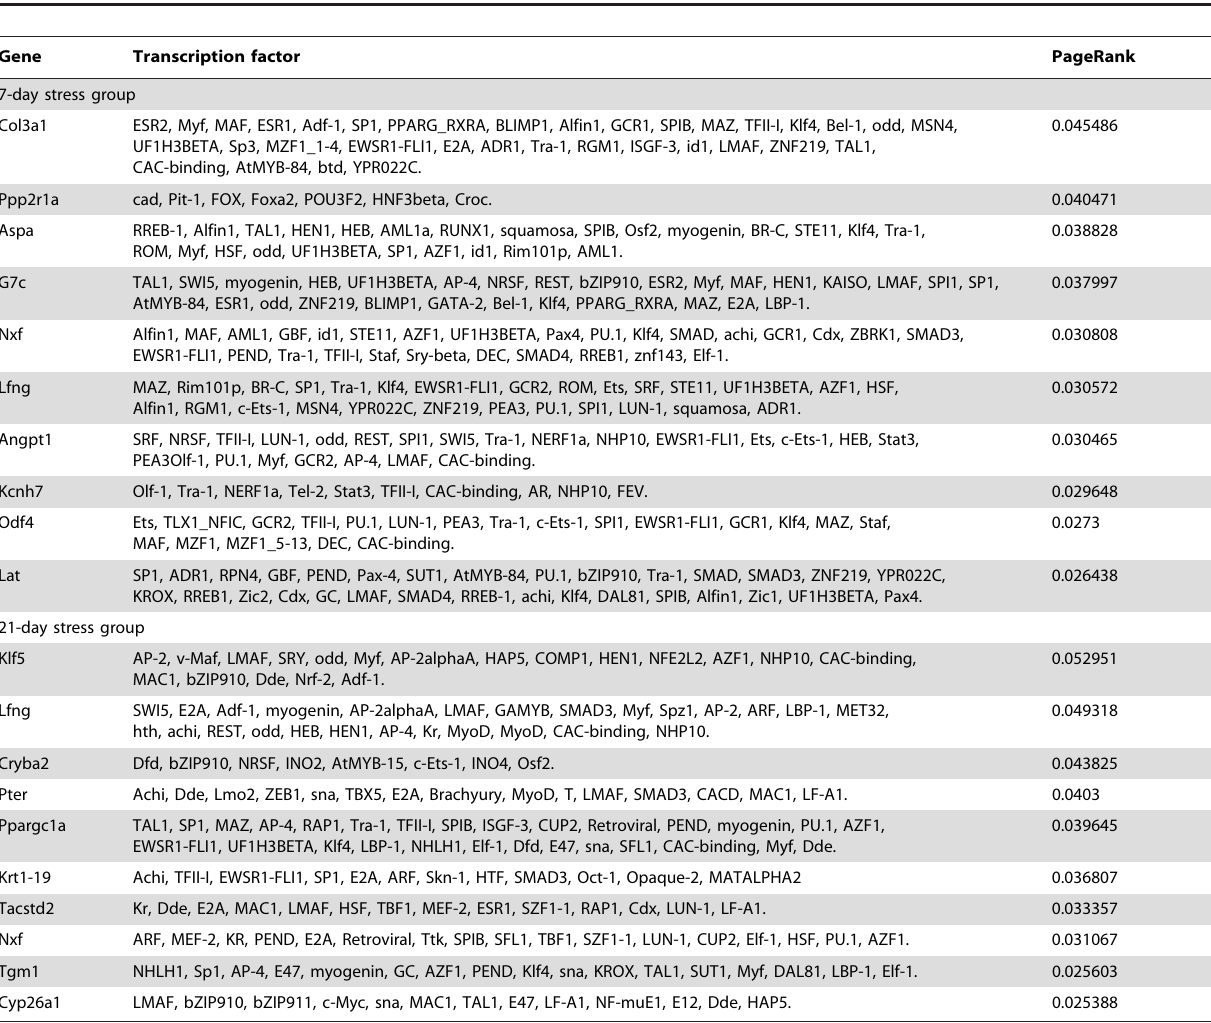
Table 3. PageRank values of the first 10 core genes in the network structure diagram and their common